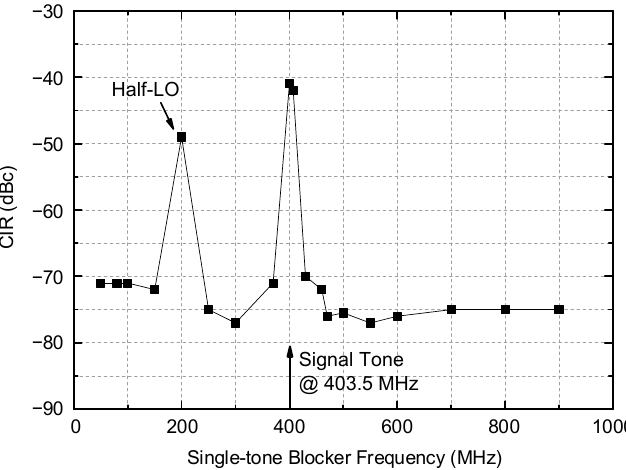
Figure 14. Measured maximum tolerable CIR against single-tone blocker. The 1 dB gain desensitization against the single-tone blocker is measured and shown in Figure 15. The worst point appearing at 403.5 MHz corresponds exactly to the input- referred 1 dB compression power ( IP 1dB ) of the receiver, which is − 40.8 dBm. As the blocker frequency moves away from the in-band, the 1 dB desensitization power continually grows from − 26.7 dBm at 350 MHz to − 9 dBm at 100 MHz for the lower band and also from − 32.7 dBm at 450 MHz to − 16.8 dBm at 900 MHz for the upper band. Figure 15. Measured single-tone 1 dB desensitization. Key performances of this work are summarized and compared with previous CMOS MedRadio receivers in Table 1. It should be noted that most of the previous works [4,5,12,14–16] did not address the OOB blocker tolerance performances. Only a few works reported selectivity performances. Cho et al. [18] reported an OOB CIR of − 30 dBc against the VHF band interference between 30 and 70 MHz, and Ba et al. [12] demonstrated the ACR performance of 15 dB in their MedRadio receiver. Huang et al. [19] reported the CIR of − 10 dB in their 915 MHz OOK receiver. Such performances should be compared to the